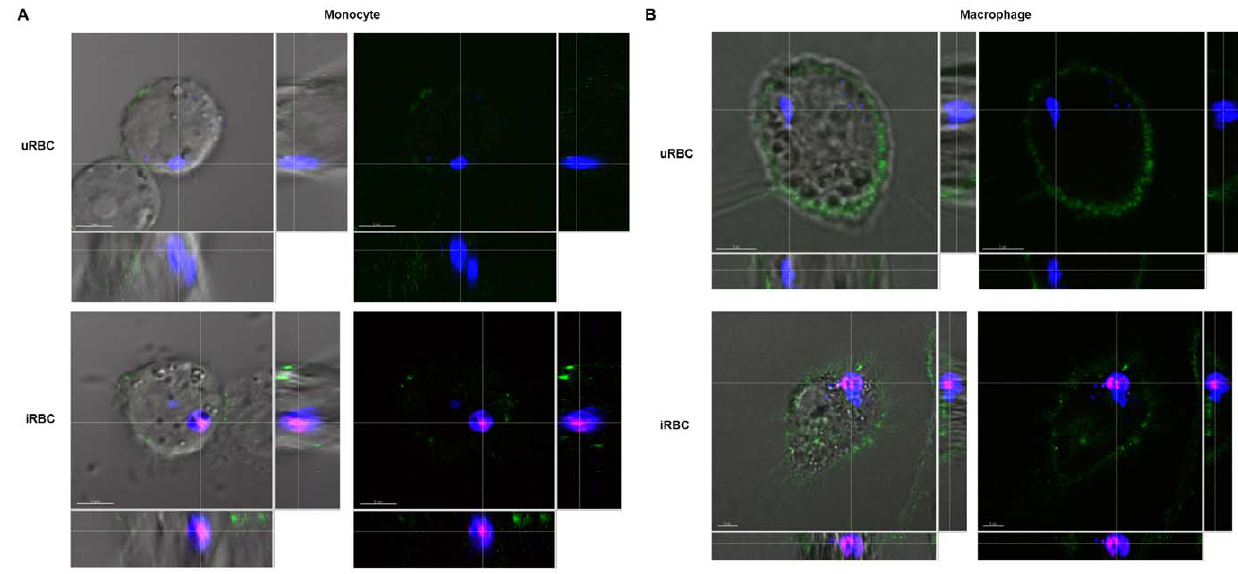
Figure 6. Confocal visualization of engulfed erythrocytes in monocytes and macrophages. Incubation of erythrocytes with phagocytes was carried out for 4 h at 37 u C with an E:T ratio of 1:100 and the phagocytes are subsequently labeled with FITC anti-human CD36 before viewing under the confocal microscope. Z-stack sections of A ) a monocyte containing a CellTrace TM Violet- labeled uRBC or an iRBC labeled with both CellTrace TM Violet and DHE, B ) a macrophage containing a CellTrace TM Violet- labeled uRBC or an iRBC labeled with both CellTrace TM Violet and DHE. (The scale bar represents 5 m m).